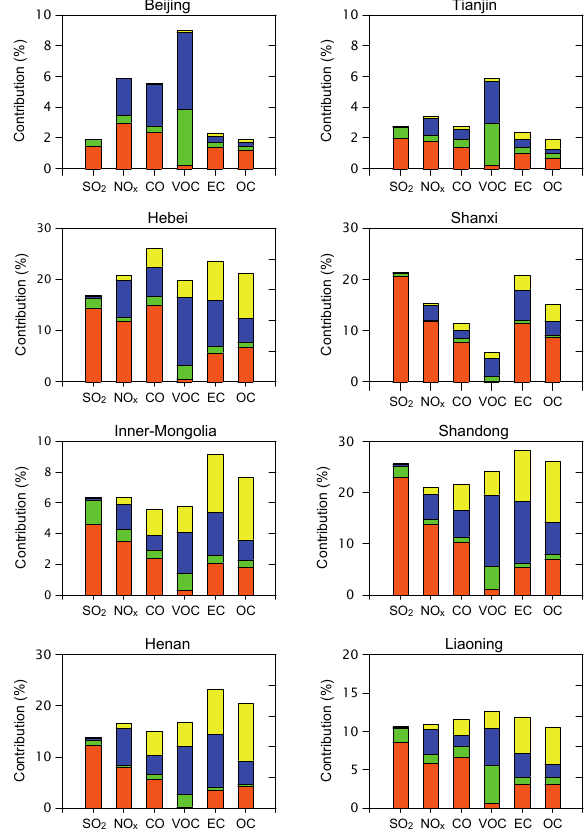
Fig. 3. Percent contributions from each province to the total emis- sions in the larger Huabei region for the year 2003. Different colours refer to the same sectors as indicated in Fig.